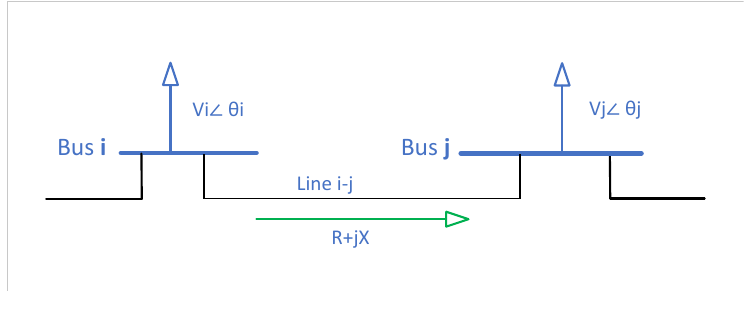
Figure 1. Fast voltage stability index calculation between two nodes [ i − j